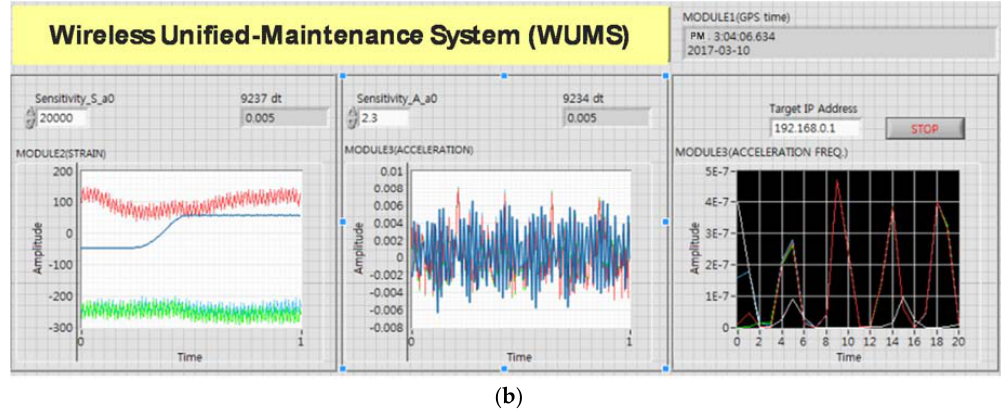
Figure 4. Host S/W for Wireless unified ‐ maintenance system (WUMS): ( a ) Host; ( b ) graphical user interface (GUI).